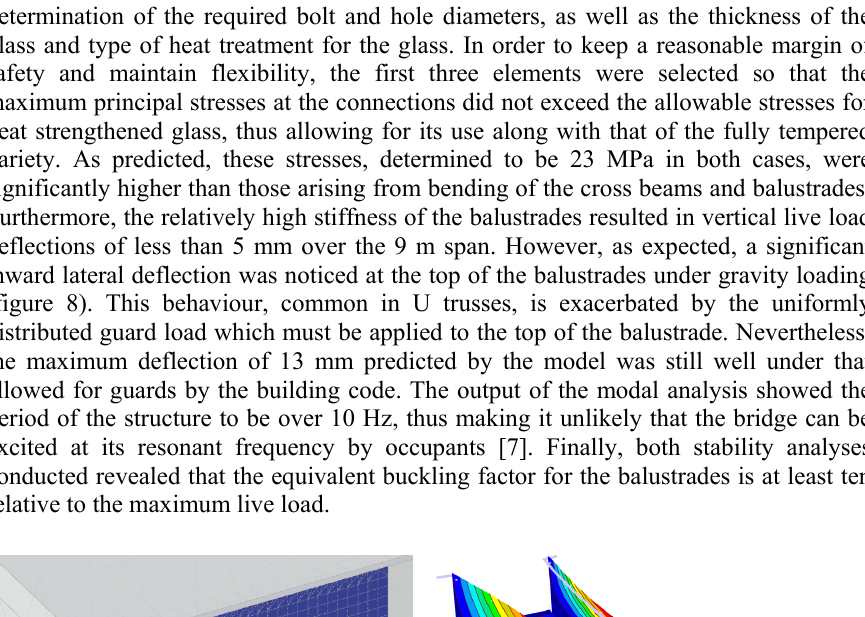
Figure 8: Deflected